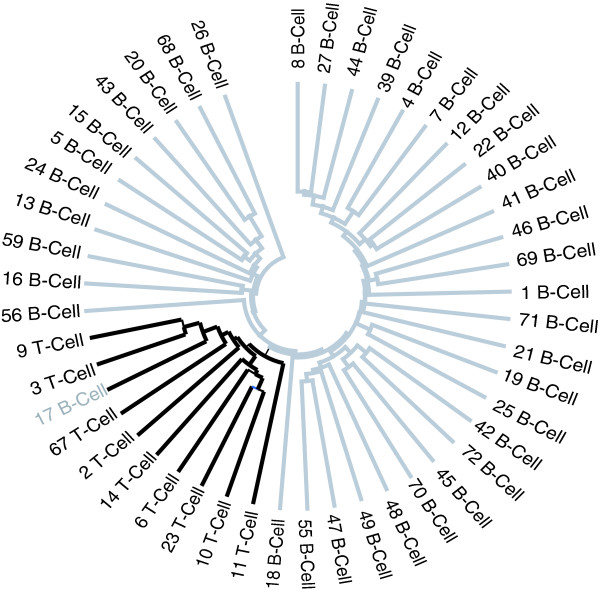
Discrimination of T-cell vs. B-cell lymphomas within the ALL leukemia samples using higher order genes. T-cell samples are clustered within a single branch, clearly separated from B-cell samples.